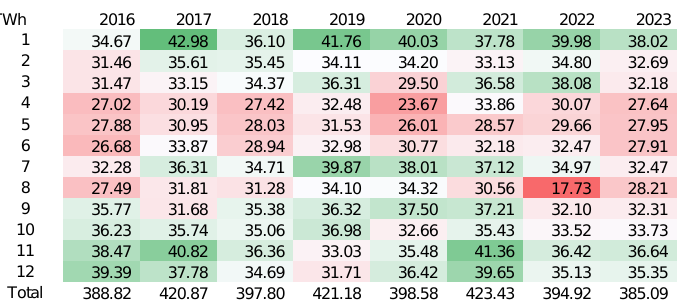
Figure 7. Negative forecast of natural gas supply to Italian end users for 2024. Forecast exercised for the period September 2022 to December 2023. These data can be found here: https://www.ec.europa.eu/ (accessed on 20 March 2022).